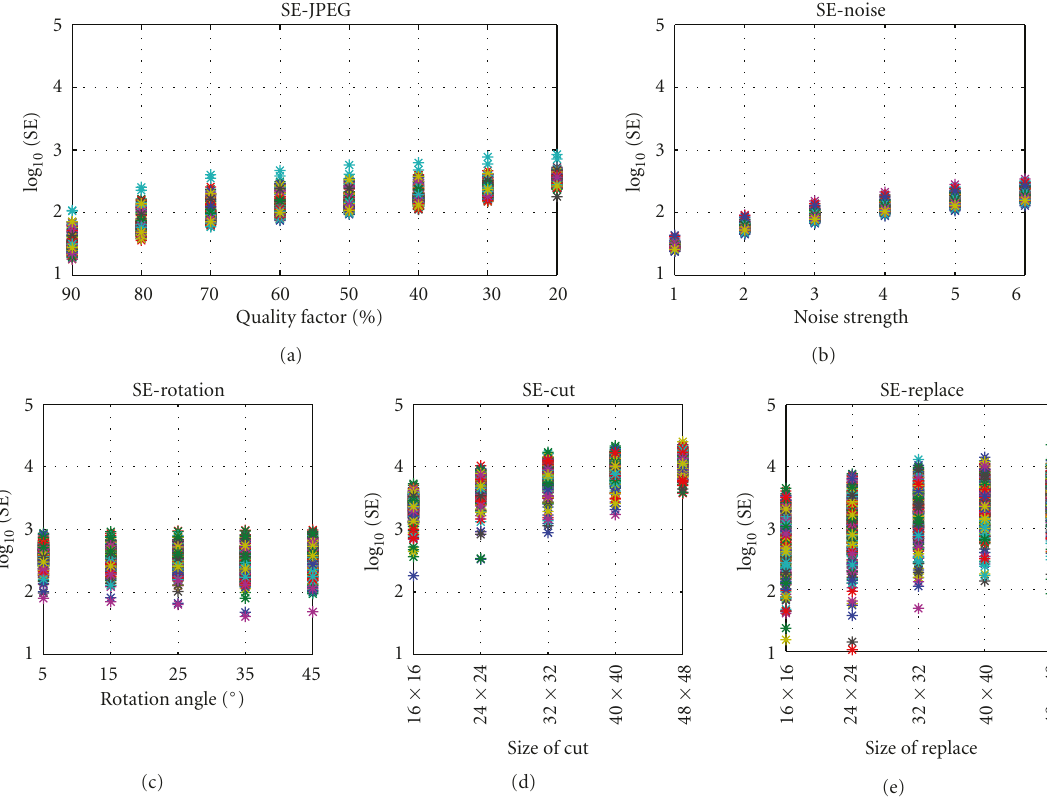
Figure 4: The distribution of SEs in order